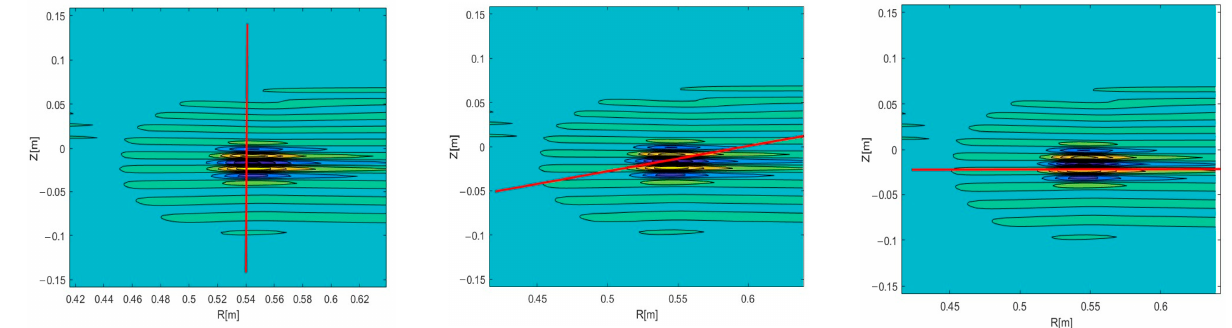
Figure 12. Two-dimensional DBS signal map for the circular filament positioned at the 48 GHz probing frequency. The red line indicates the trajectory: ( left ) poloidal motion, ( middle ) motion in both the poloidal and radial directions, ( right ) radial motion.